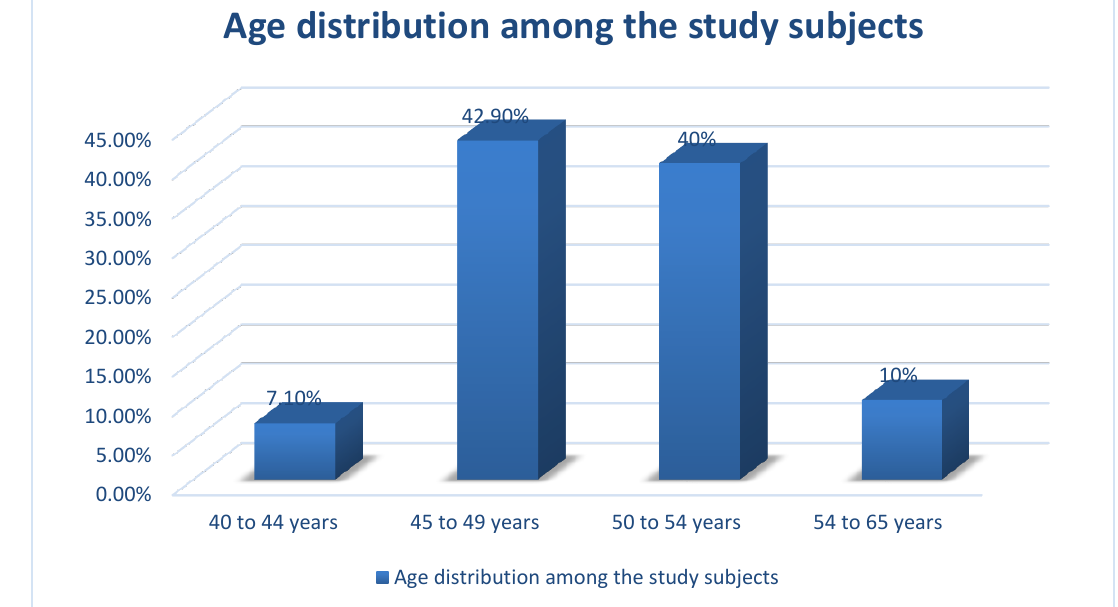
Fig. 2. Distribution of age among the 70 study